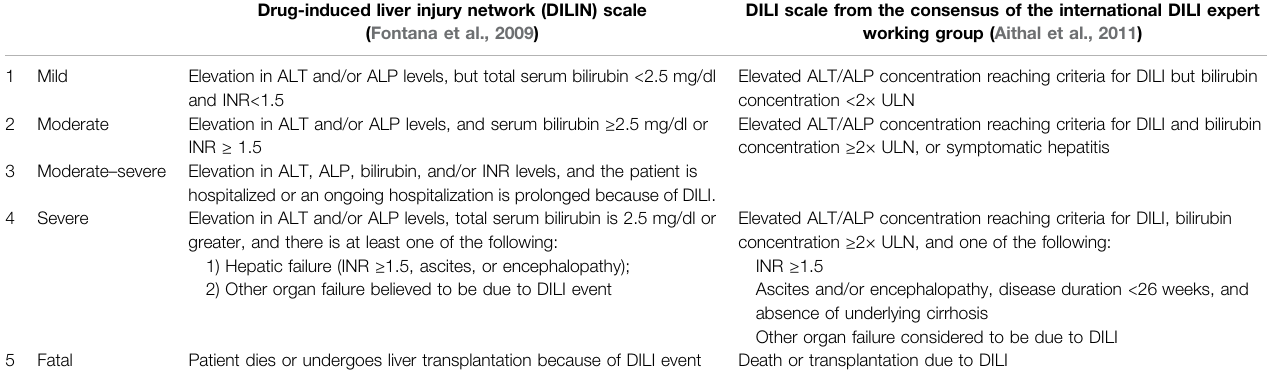
TABLE 4 | DILI scale. Adapted from Fontana et al. (2009) and Aithal et al. (2011). Drug-induced liver injury network (DILIN) scale (Fontana et al., 2009) Elevation in ALT and/or ALP levels, but total serum bilirubin < 2.5 mg/dl and INR < 1.5